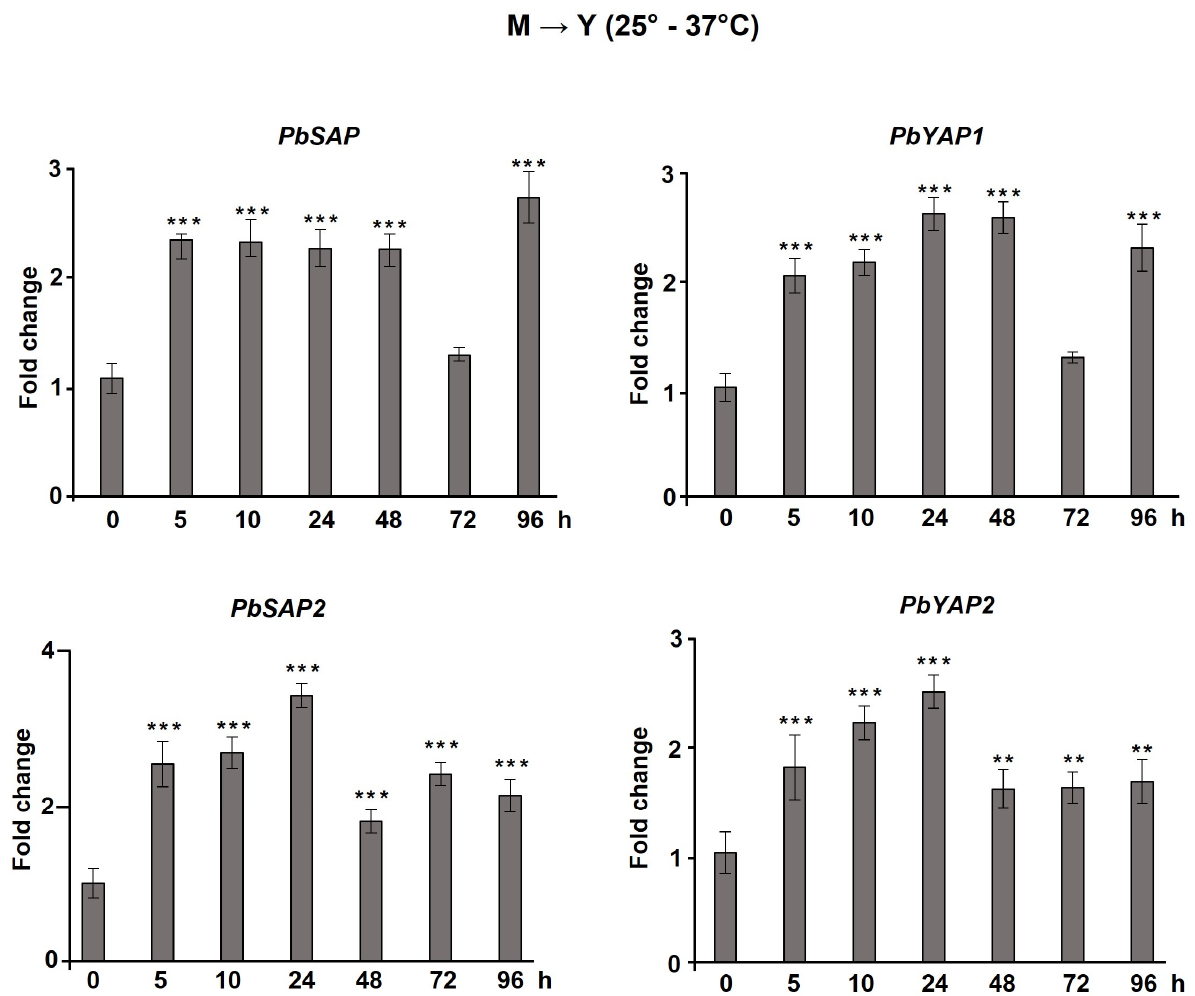
Figure 3. Expression of aspartic protease genes in P. brasiliensis during transition of mycelium to yeast (M → Y). PbSAP (PADG_00634), PbSAP2 (PADG_03432), PbYAP1 (PADG_12056), and PbYAP2 (PADG_08282) transcript levels were measured during the mycelium-to-yeast (M → Y) transition. The change in transcriptional levels was calculated via the 2 − ∆∆ Ct method, with two housekeeping genes ( α -TUB and 18S ). All of the data shown in this figure were analyzed using ANOVA (analysis of variance) with Dunnet’s post hoc test. Error bars correspond to the standard deviation of measurements performed in triplicate, and asterisks indicate statistically significant differences in expression (** p ≤ 0.01 and *** p ≤ 0.001). The results shown are representative of three independent exper-